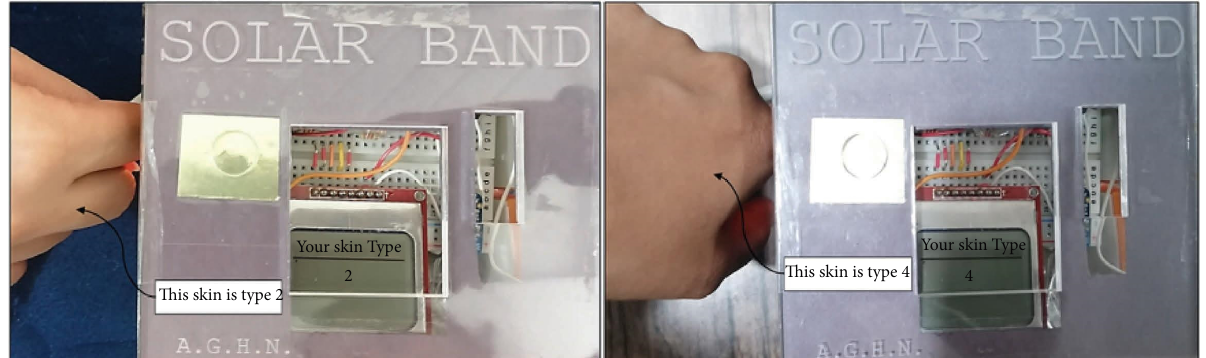
Figure 12: Detected skin type of volunteers using the prototype.